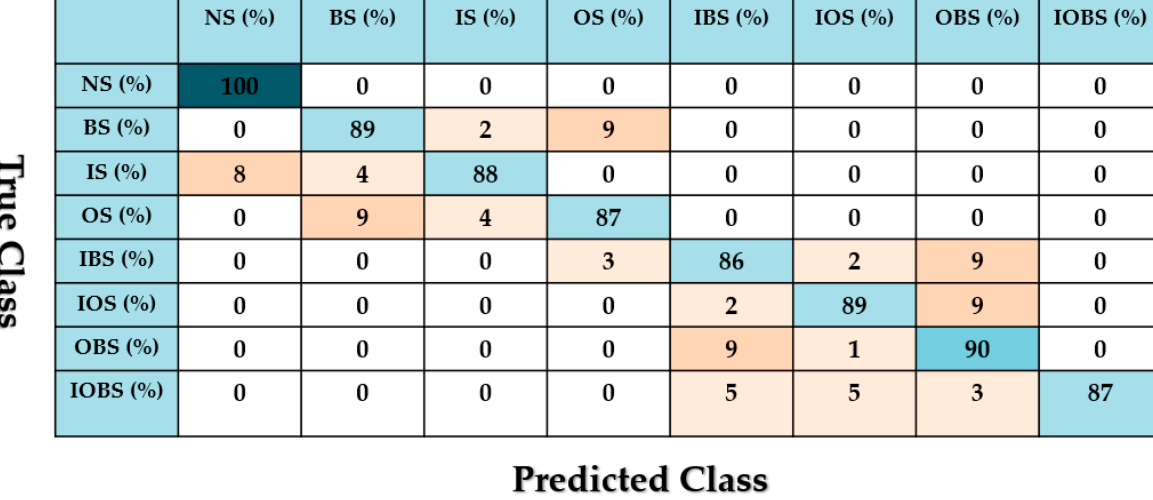
Figure 14. The average of anomaly diagnosis using the combination of sliding digital twin and SVM. Table 4. Comparison between the combination of the proposed smooth sliding digital twin and SVM, high-order sliding digital twin and SVM, and sliding digital twin and SVM for anomaly diagnosis.